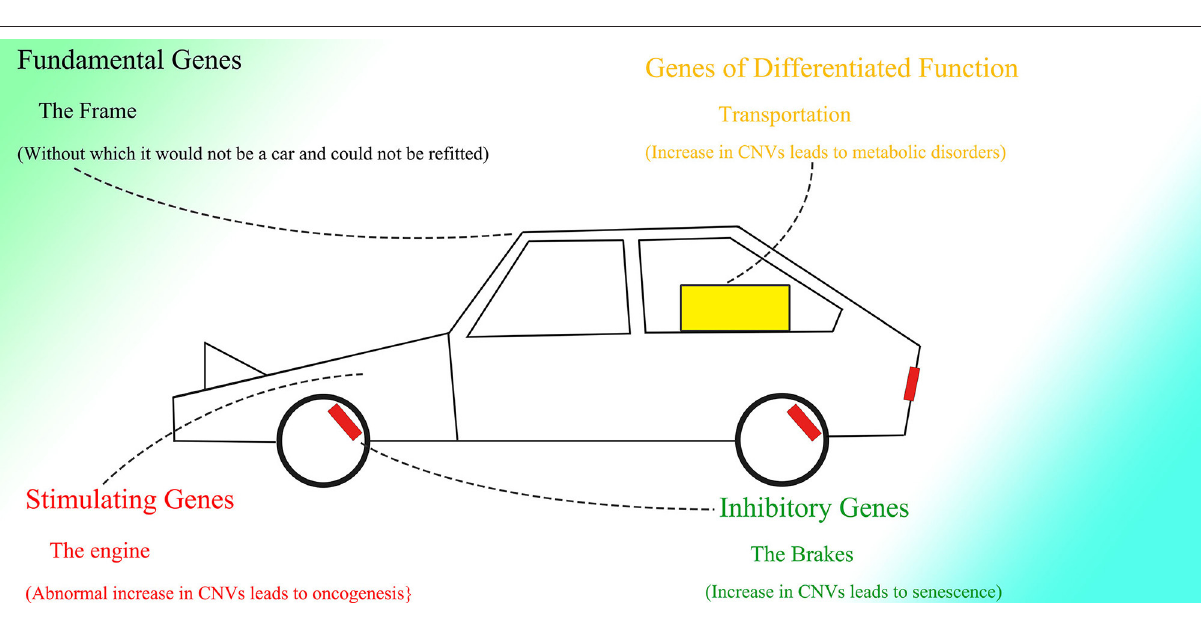
FIGURE 12 | The entire genome might be compared to a car. The frame (the fundamental genes) cannot be altered. A modified engine (increased CNVs of stimulating genes) results in increased speed (oncogenesis). The brakes (inhibitory genes) slow the car down (cause the organism to become senile). The genes of differentiated functions can also be